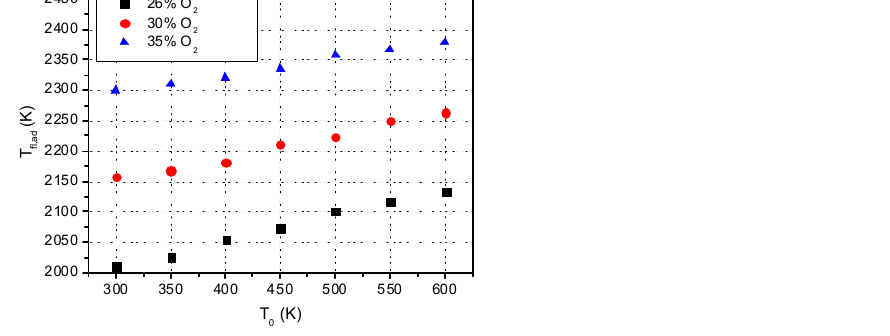
Figure 20. The adiabatic flame temperature variation with initial temperature for oxygen-enriched biogas mixtures.